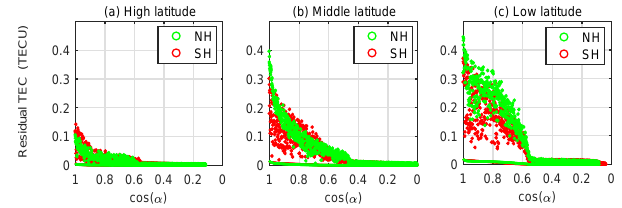
Figure 6. Residual TEC along the signal path with tangent point in the high-latitude area (a) , middle-latitude area (b) and low-latitude area (c) in the Southern Hemisphere (SH) (red circles) and the Northern Hemisphere (NH) (green circles).